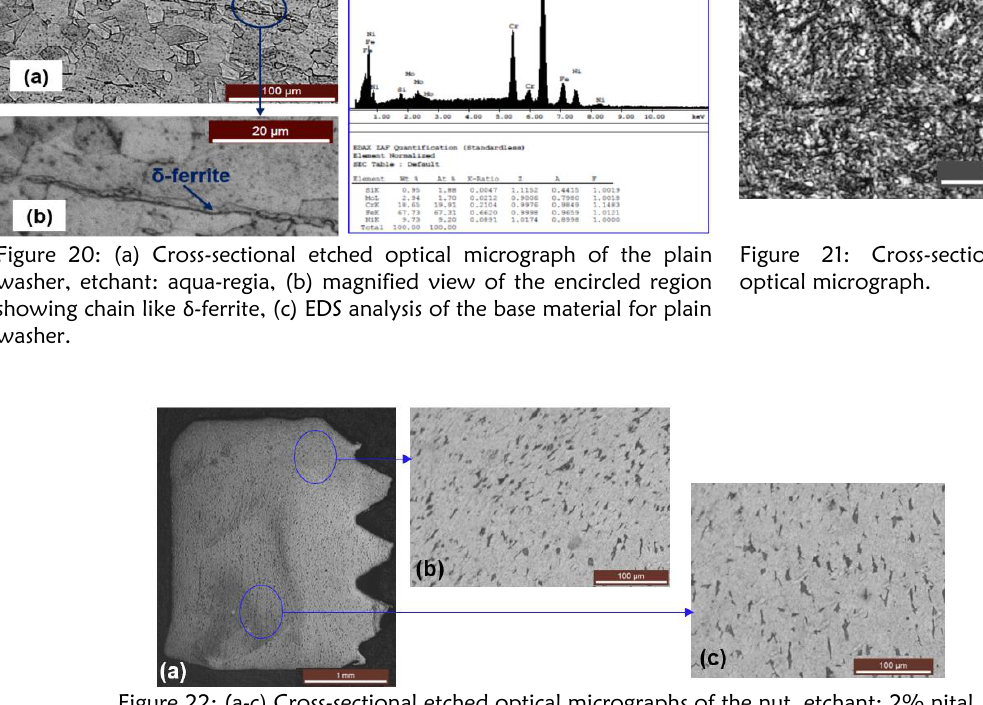
Figure 22: (a-c) Cross-sectional etched optical micrographs of the nut, etchant: 2%